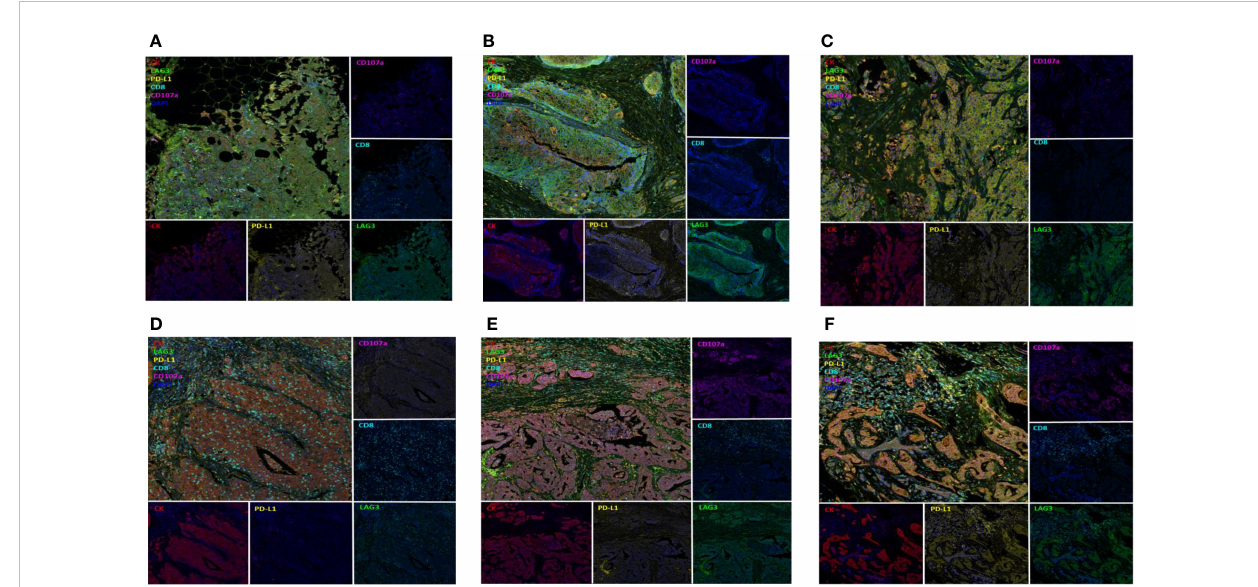
FIGURE 7 Multiplex Immunohistochemistry according to ICI response; Figures on upper column (A – C) presented TNBC with LAG3 expression (green, EPR4392, Abcam) not related to CK+ cells (red, AE1/AE3, DAKO) and having long ICI-PFS whereas fi gures on lower column (D – F) presented TNBC with LAG3 expression on CK+ cells and having short ICI-PFS.